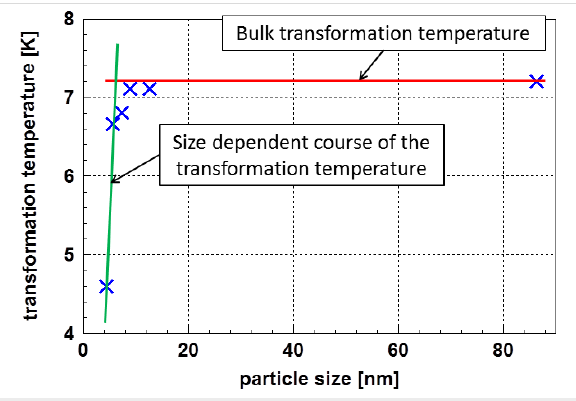
Figure 5: The transformation temperature in lead from normal to superconducting as a function of the particle size according to Li et al. [8]. Below ≈ 6 nm, a transition to a particle size dependent range is clearly visible.